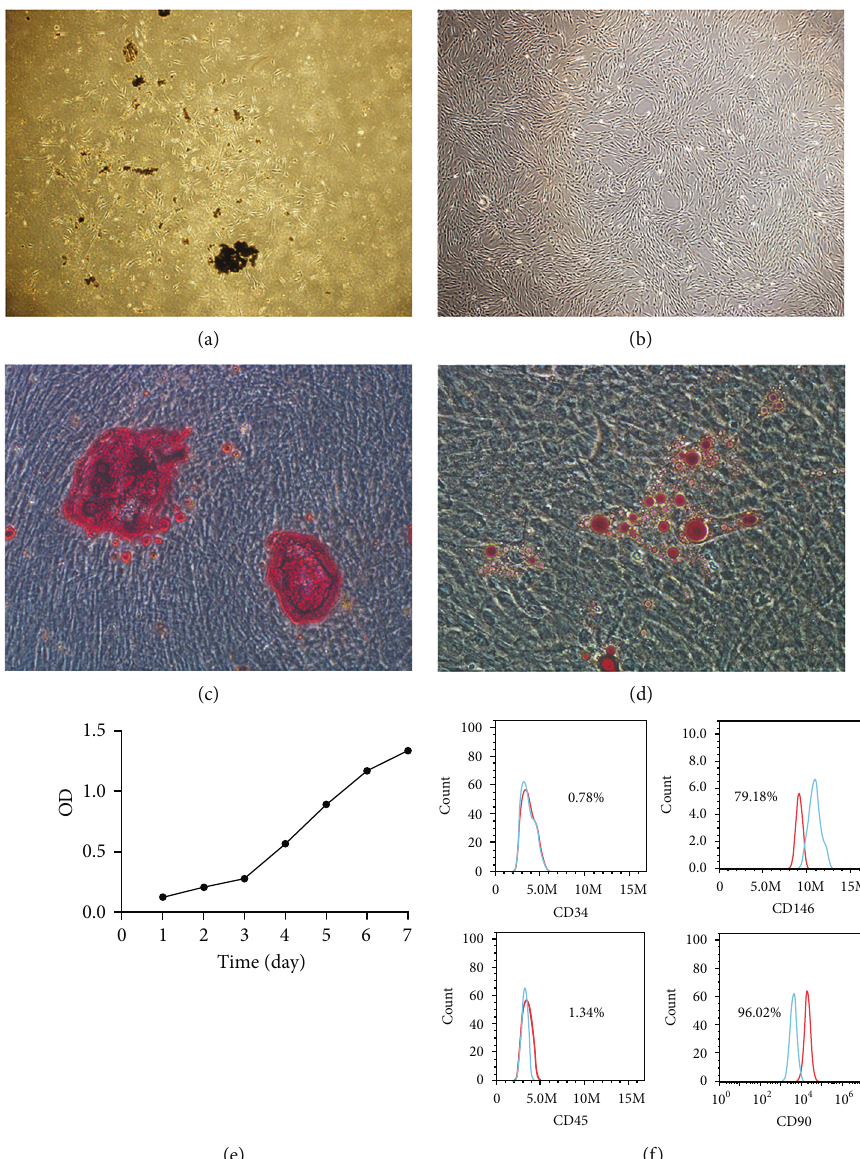
Figure 1: Isolation and characterization of hPDLSCs. (a) Morphology of hPDLSCs after culturing the cells for 7 days. Original magni fi cation × 40. (b) Morphology of the subcultured cells. Original magni fi cation × 40. (c) Cultured hPDLSCs formed alizarin red- positive calcium deposits after 3 weeks of culture in osteogenic induction medium. Original magni fi cation × 100. (d) Cultured hPDLSCs formed oil red O-positive lipid clusters after 3 weeks of culture in adipogenic induction medium. Original magni fi cation × 100. (e) The growth curve is presented in an “ S shape. ” (f) The positive expression rates of negative markers CD34 and CD45 were 0.78% and 1.24%, respectively; the positive expression rates of positive markers CD146 and CD90 were 79.18% and 96.02%, respectively. OD: optical density; hPDLSCs: human periodontal ligament stem